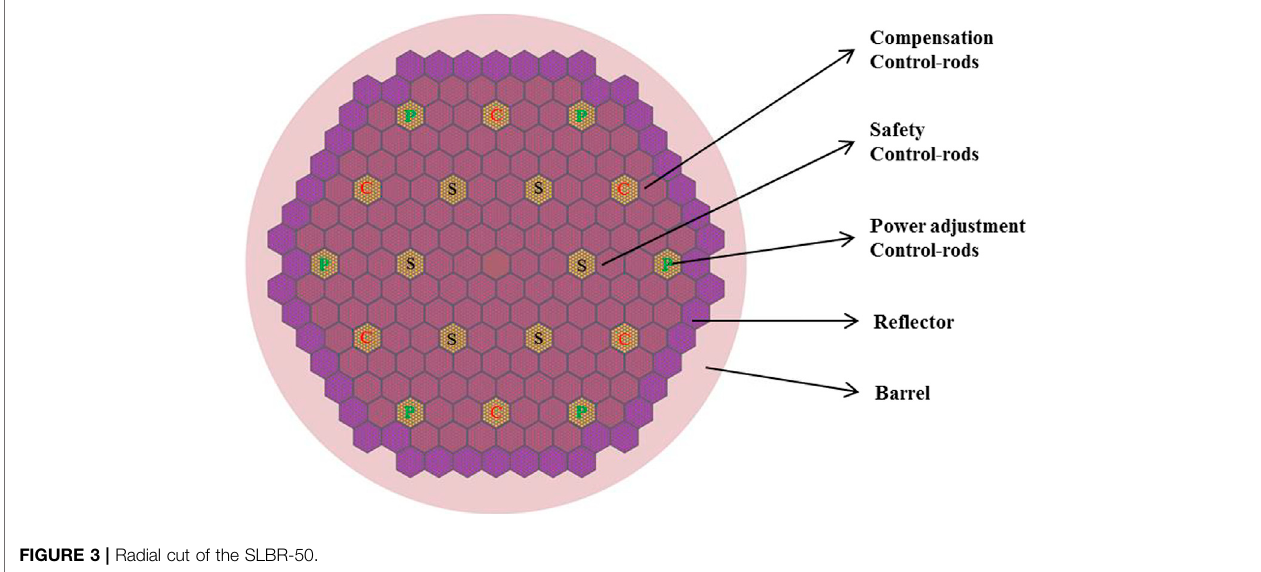
FIGURE 3 | Radial cut of the SLBR-50.